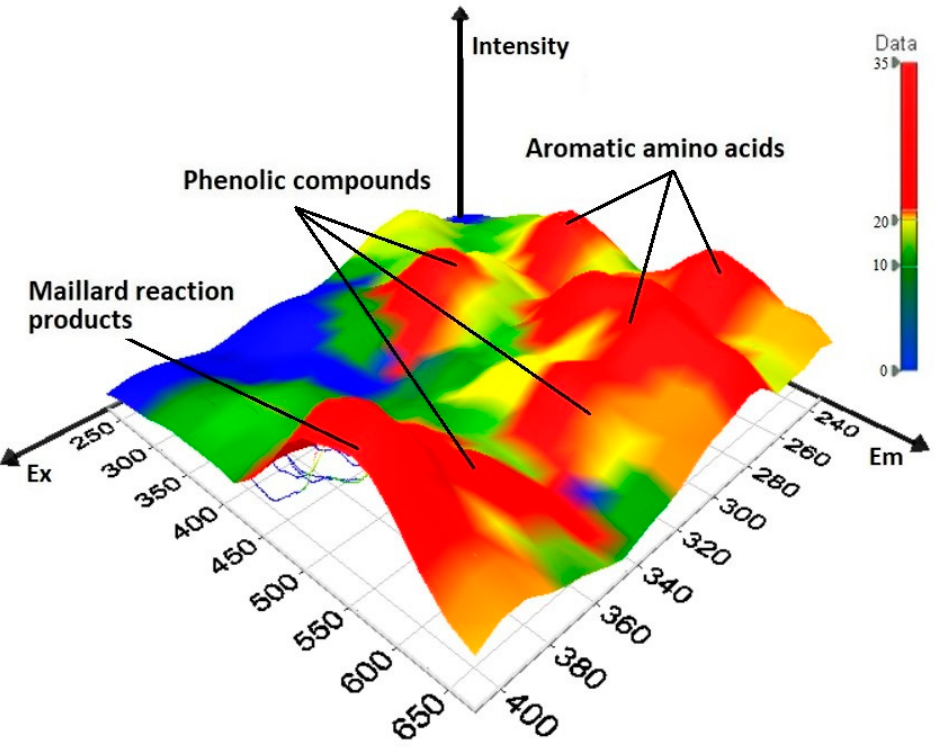
Figure 5. The 3D-EEM spectra intensities at λ ex = 240–400 and λ em =